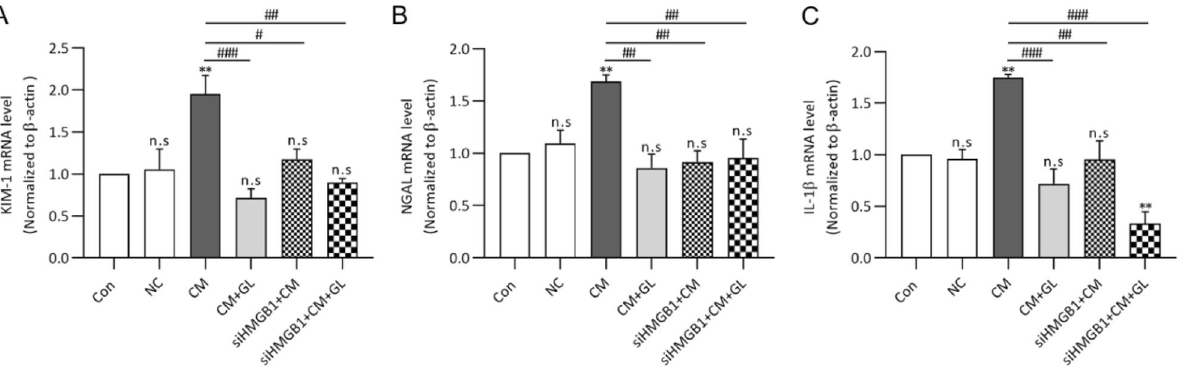
Figure 9. Knocking down HMGB1 inhibits the mRNA expression of kidney injury markers after contrast media exposure. (A-C) The mRNA expressions of KIM-1, NGAL and IL-18 mRNA were measured using RT-PCR. Similar to pro-inflammatory cytokines, the mRNA expression of kidney injury markers did not significantly increase after cells were exposed to contrast media or contrast media + glycyrrhizin after knocking down HMGB1. Results were expressed as means ± SEMs for the three independent experiments, which were each performed in duplicate. Statistical significance: ** P < 0.01 Con vs siHMGB1 + CM + GL. # P < 0.05, ## P < 0.01 and ### P < 0.001, CM vs CM + GL, CM vs siHMGB1 + CM, CM vs siHMGB1 + CM + GL. Abbreviation: NC, negative control; CM, contrast media; GL,